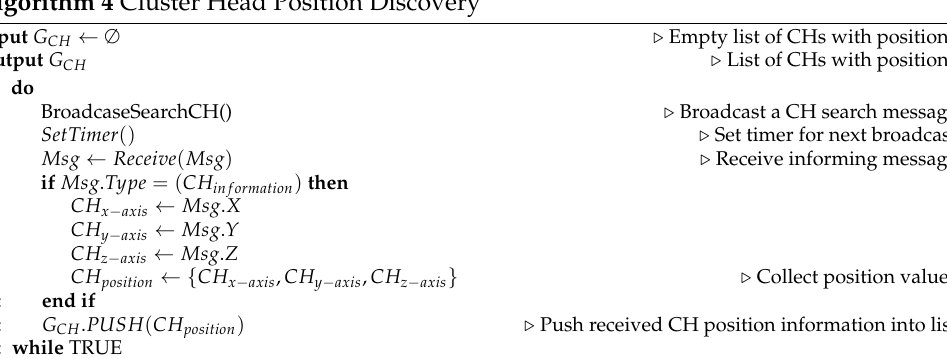
Algorithm 4 Cluster Head Position